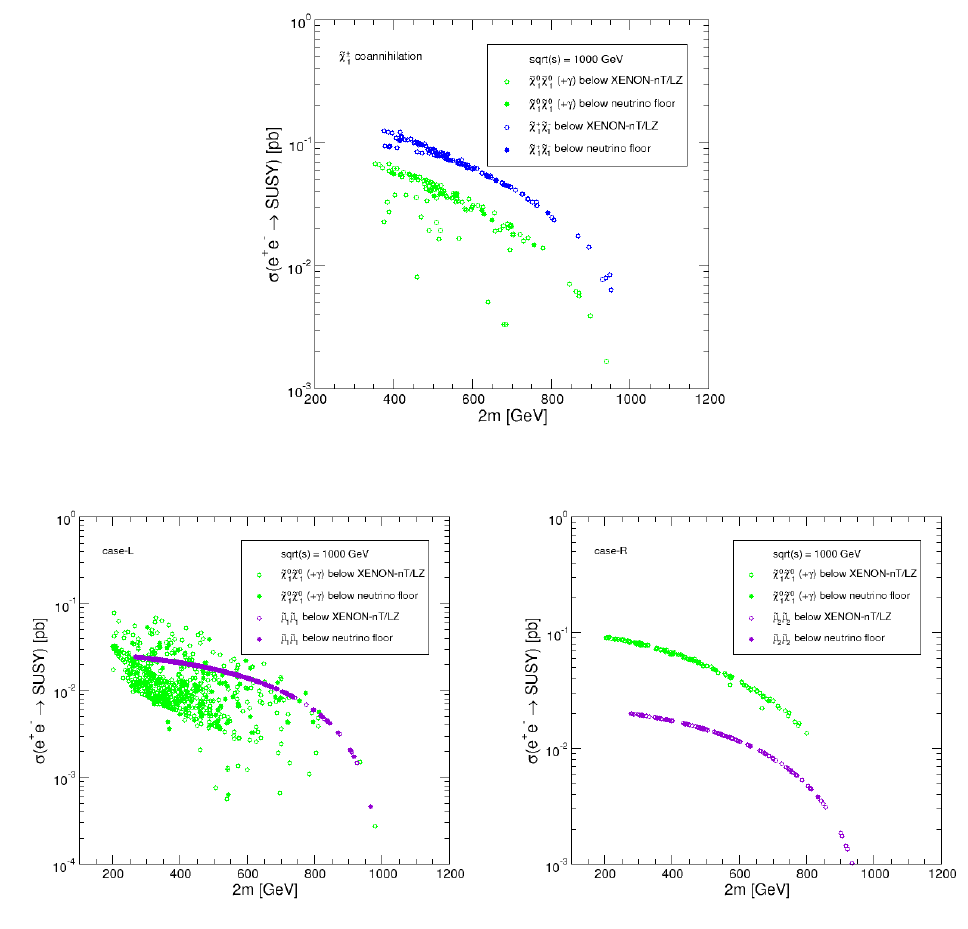
Figure 4. Cross section predictions at an e + e − collider with √ s = 1000 GeV as a function of the sum of two final state masses. Upper plot: ˜ χ ± coannihilation scenario; lower left plot: ˜ l ± 1 − case L; lower right plot: ˜ l ± coannihilation case R. The color code indicates the final state, open − − − circles are below the anticipated XENON nT/LZ reach, and full circles are below the neutrino −